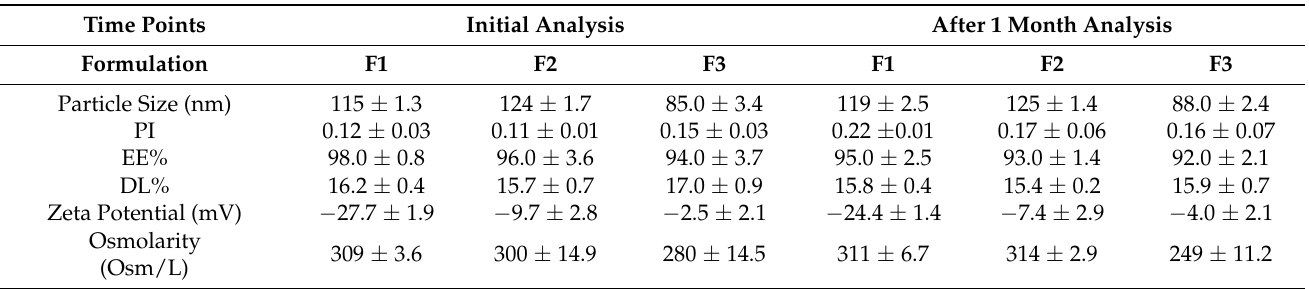
Table 2. One month stability at 4 ◦ C under N 2 and protected from light. Values represented as mean ± SD, n =